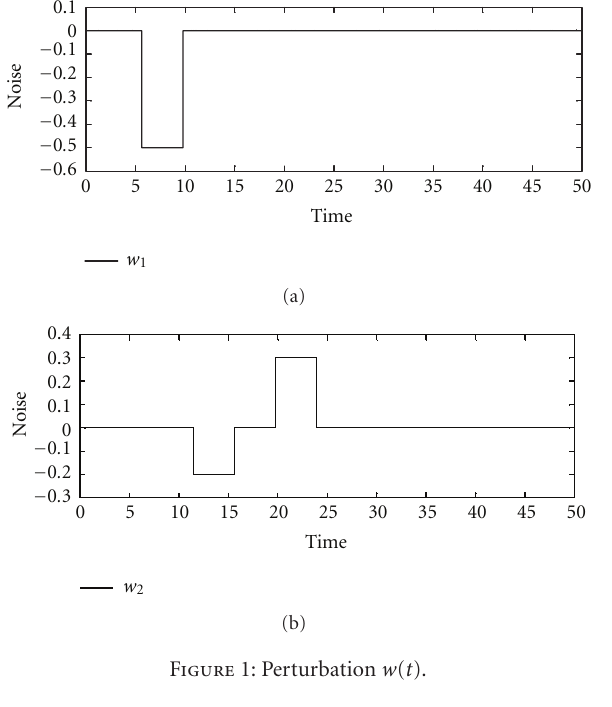
Figure 1: Perturbation w ( t ).